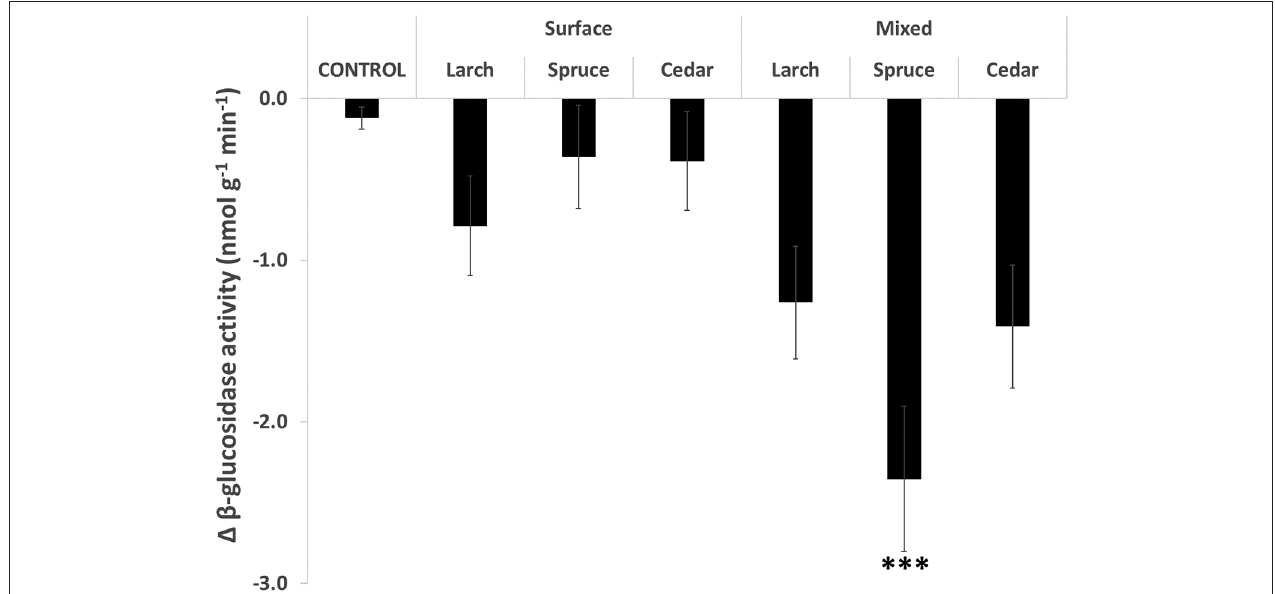
FIGURE 2 | Mean change in activity of β -glucosidase over the period September 2013 to July 2014 ( n = 5). Significance levels: *** p < 0.001.